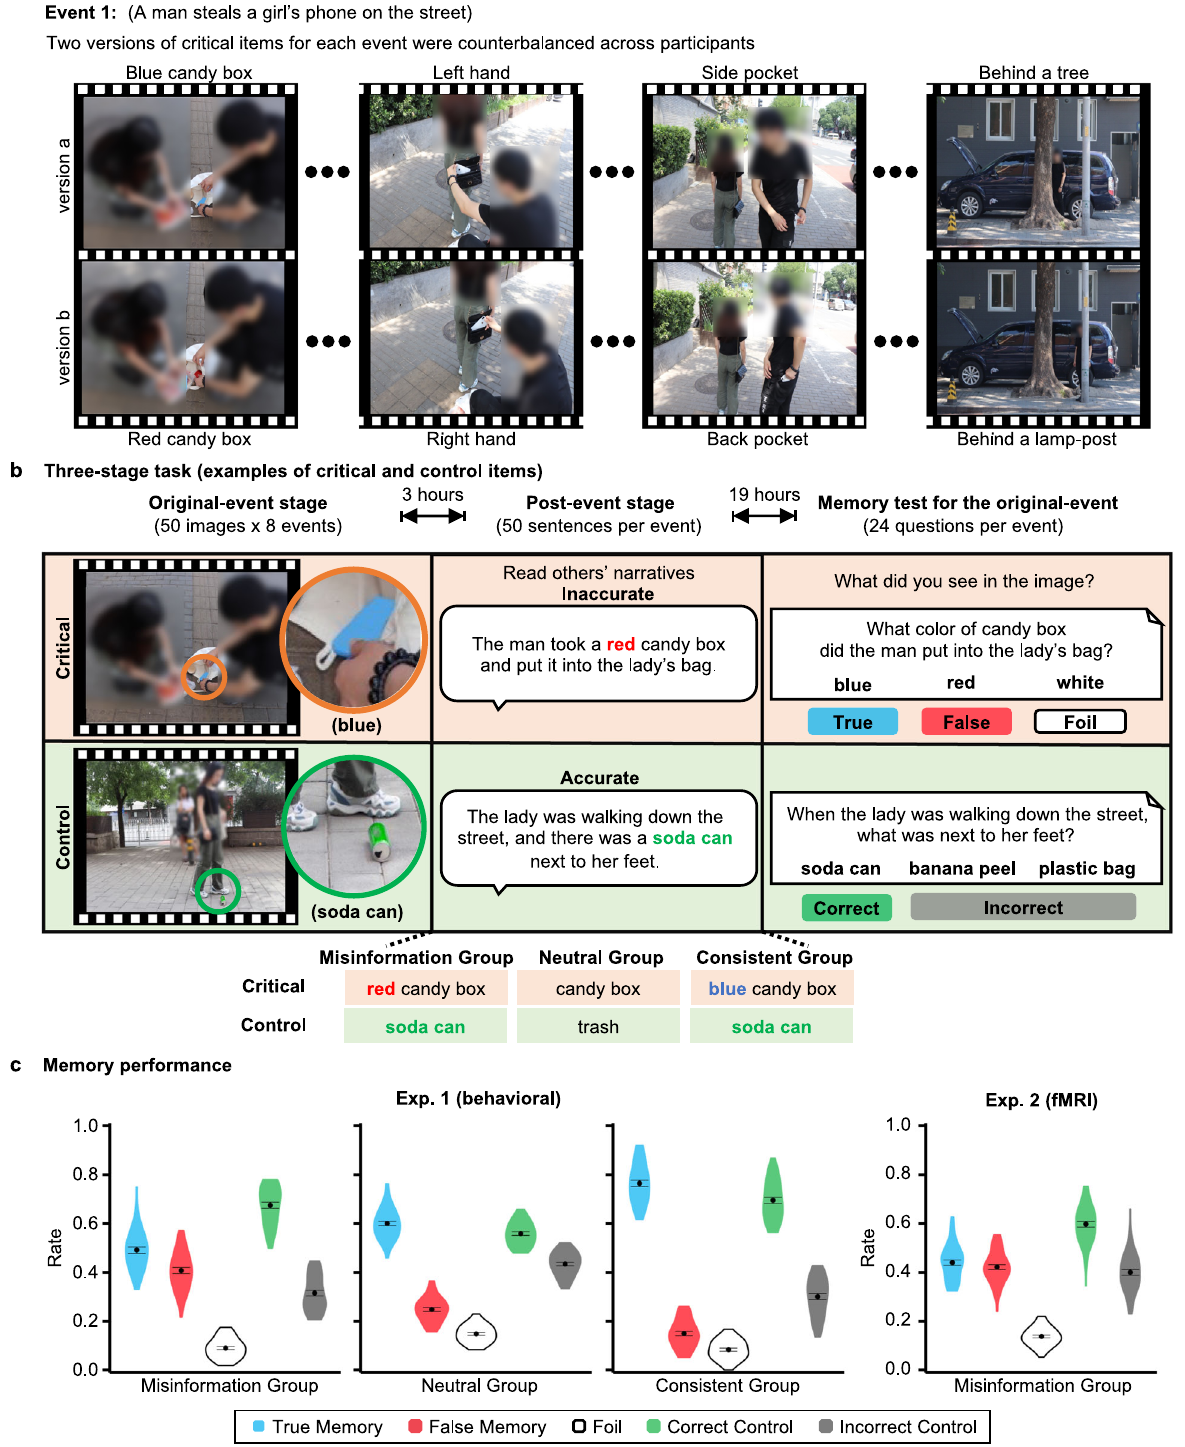
Fig. 2 | Experimental design and behavioral results of the misinformation effect. a Materials of original events. Images of people in the fi gure are blurred according to journal ’ s regulations, while images in the experiment were displayed in high resolution. b Procedure and manipulation. Critical items are shown in light orange and control items are shown in light green. True memory, false memory, foil,correctcontrol,andincorrectcontrolareshowninblue,red,white,darkgreen, and gray, respectively. c Memory performance. Data are visualized as violin plots